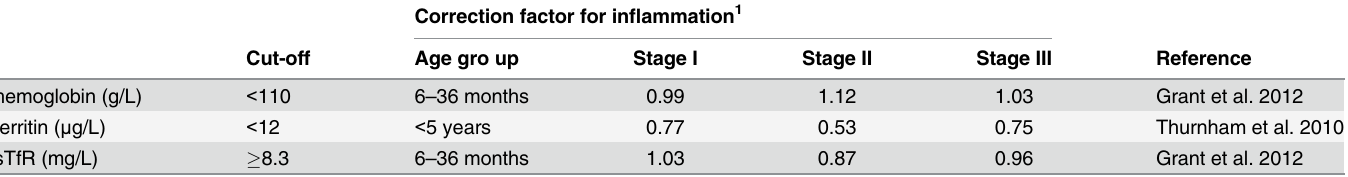
Table 1. Cut-offs and correction factors for hemoglobin, ferritin, and sTfR